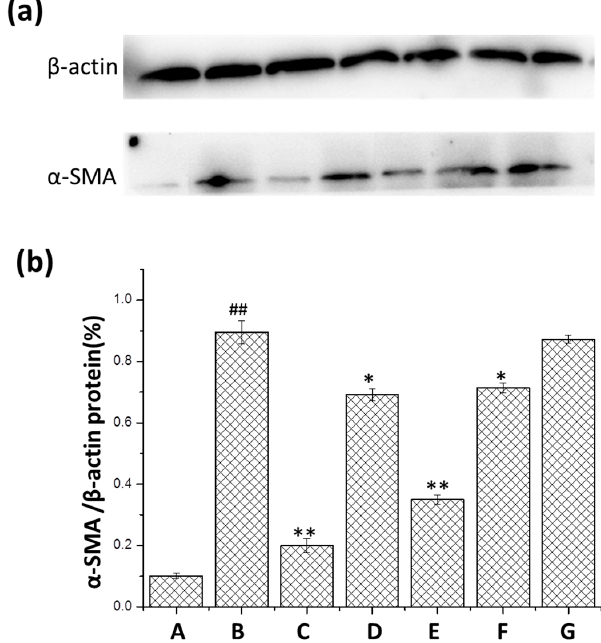
Figure 7. Effect of m KG on the expression of α -SMA in the lung tissues of BLM-induced pulmonary fibrosis mice by Western blot analysis. ( a ) The α -SMA expressions in the lung tissues were detected by Western blot analysis; ( b ) The quantitative result of the α -SMA expression. Data were expressed as mean ± S.D. ## p < 0.01 compared with the control group. * p < 0.05, ** p < 0.01 compared with the BLM group. (A) Normal group; (B) BLM group; (C) Pirfenidone group; (D) Dexamethasone group; (E) m KG-H group; (F) m KG-M group; (G) m KG-L group.